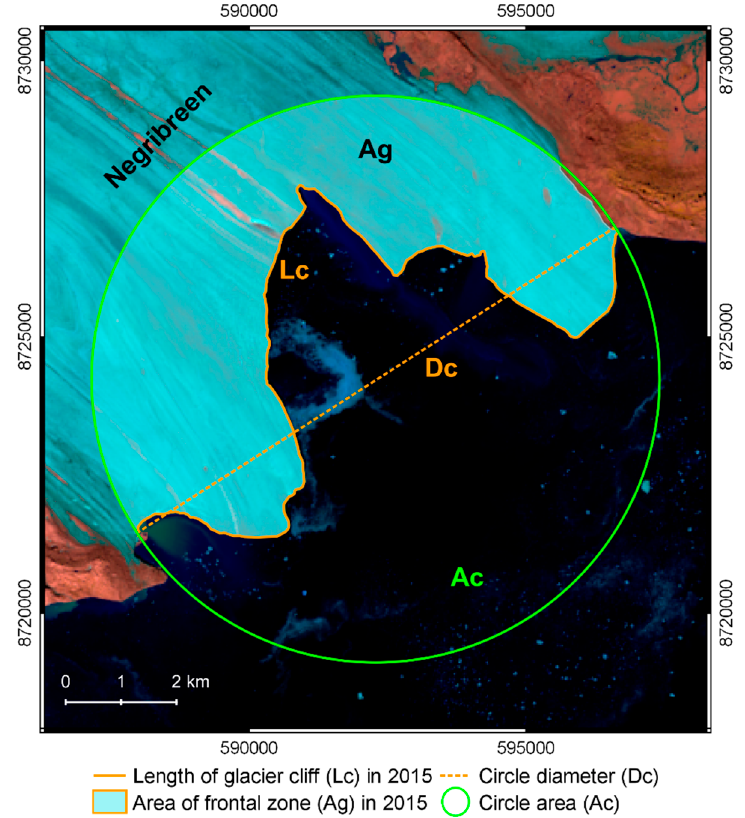
Figure 1. Frontal zone Ag of Spitsbergen tidewater glaciers on the example of Nigerbreen (based on the 654 spectral bands composition of the Landsat 8 satellite imagery ID: LC82150032015238LGN01, 26.08.2015, USGS/NASA Landsat [41].